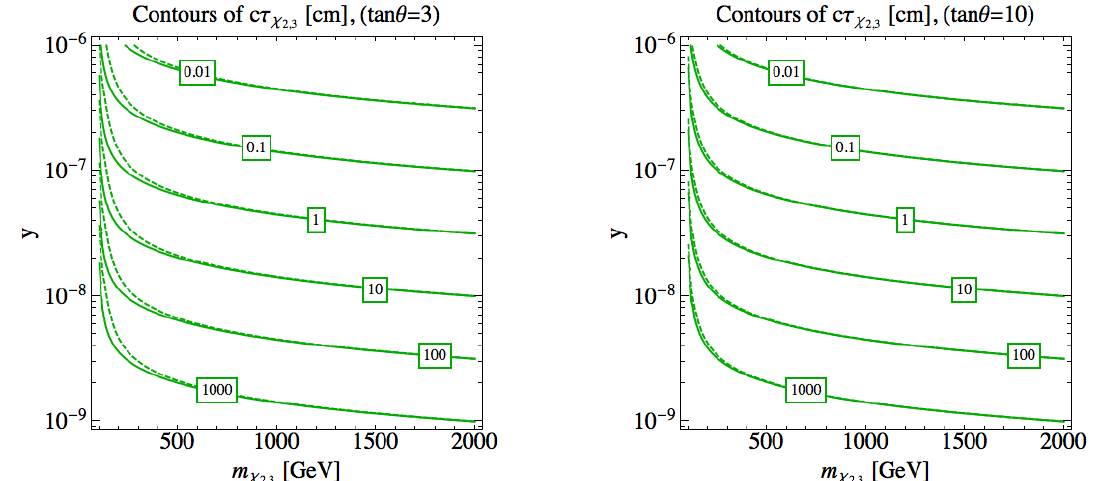
Figure 3 . Decay length of the two heavy neutral fermions, (cid:31) lines) for two di(cid:11)erent choices of tan (cid:18) = y u =y d . The mass of the lightest neutral fermion is set to = 10 m (cid:31) 1